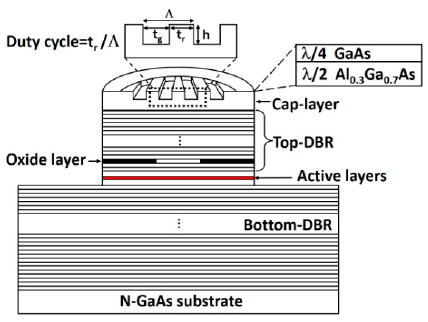
Figure 1. Schematic structure of a vertical-cavity surface-emitting lasers (VCSEL) with a surface grating period Λ , depth h , groove width t g , and ridge width t r , the duty cycle is defined by t r / Λ .